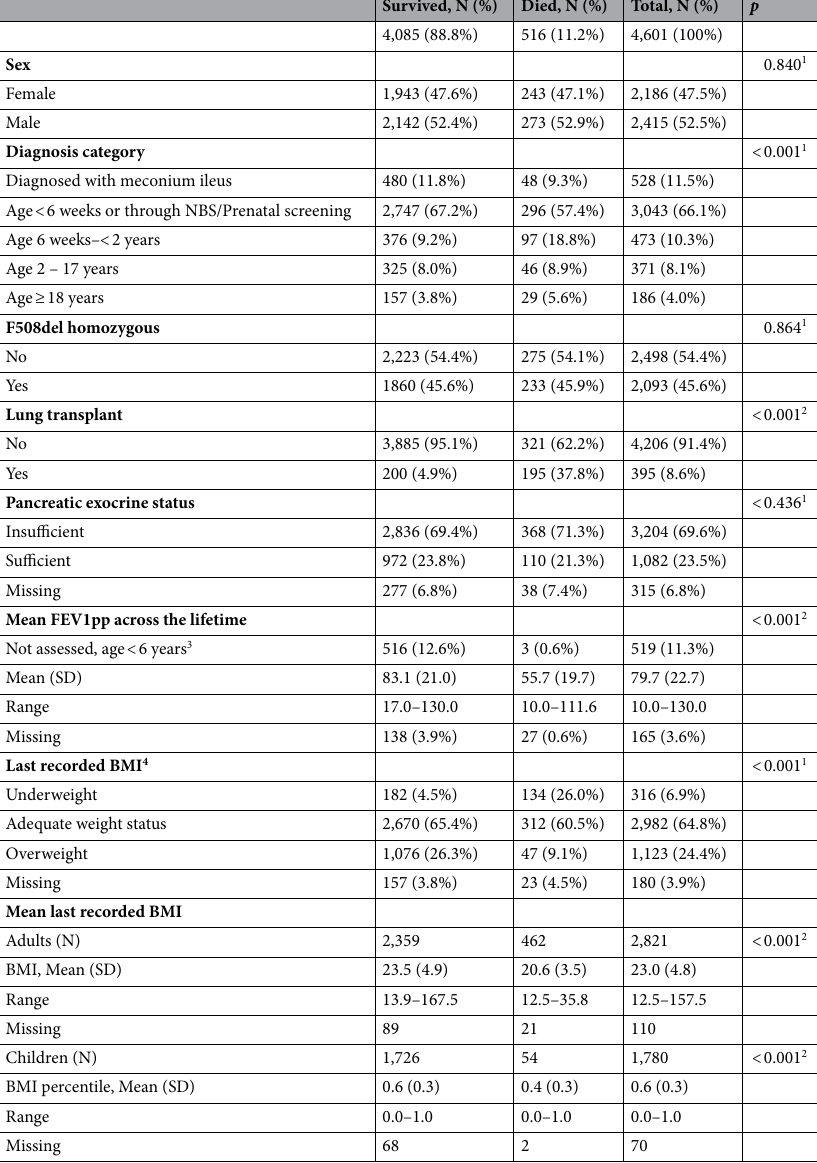
Table 1. Demographic and clinical variables of the study population, 2005–2020. BMI body mass index,